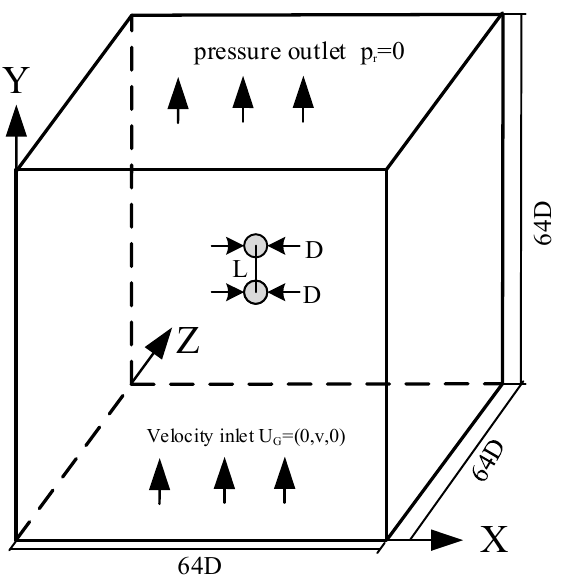
Figure 2. Schematic diagram of the relative position of two droplets in tandem. Based on our previous study [16] and the simulations conducted by K é kesi et al. [14,15] and Jiao et al. [10], a scheme of six levels was used to locally refine the computation region— the grid size of the inner computation region was halved when a new level was added. The maximum length of the grid was D and the minimum grid length was 1/32D, as shown in Figure 3. Four kinds of droplet separating space were simulated at this time: L/D = 1.5, 2, 3, and